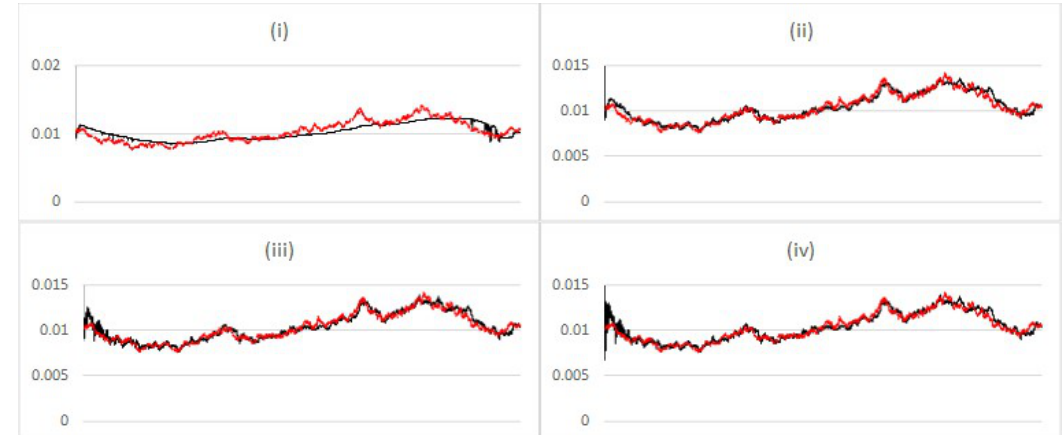
Figure 7. Comparing estimated expected value (black) vs. simulation input value (red) of α in the stochastic volatility model for the Liu and West filter with additional noise parameter φ ( i ) ∼ U ( 0, c ) with c set to ( i ) 0.2